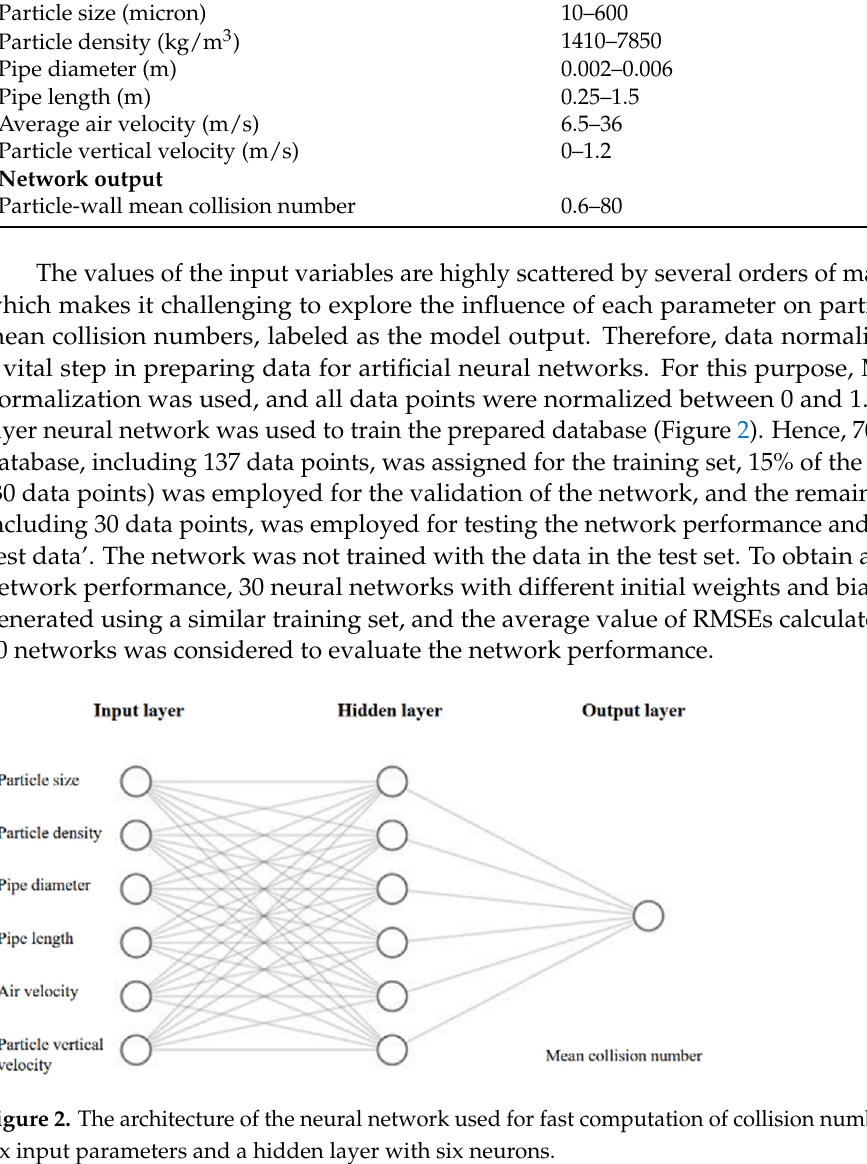
Table 1. Network inputs and output.